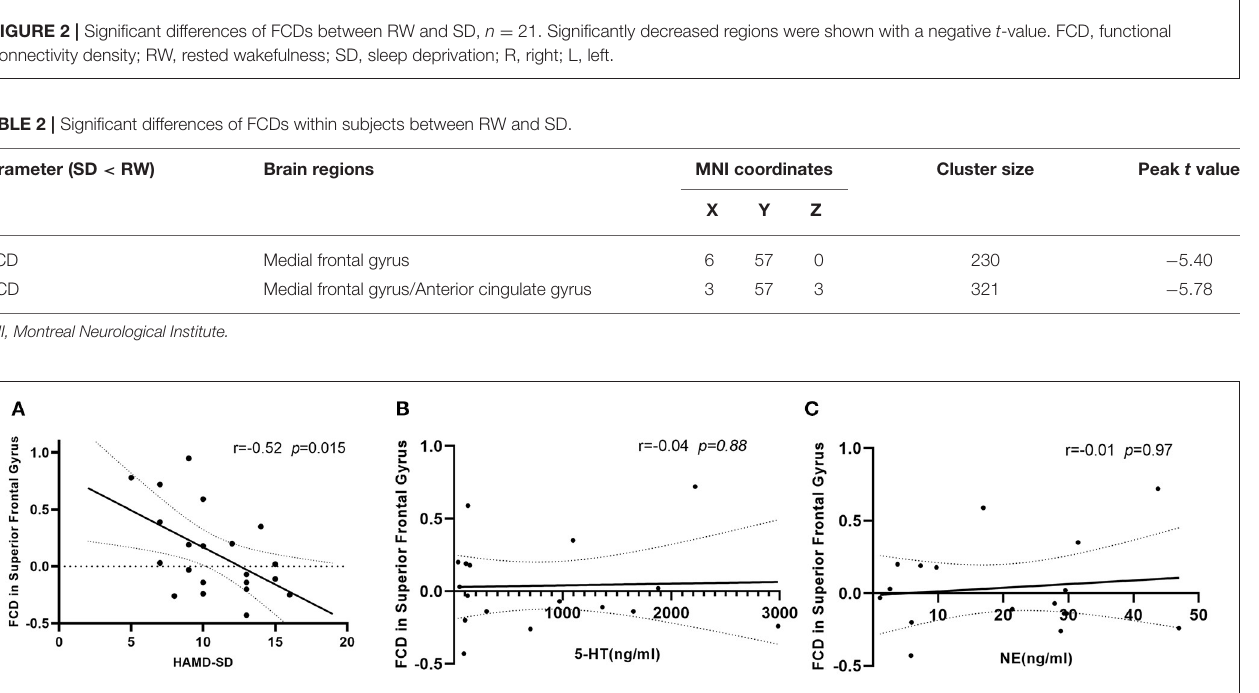
FIGURE 3 | (A) Correlation between value of lrFCD in right medial frontal gyrus and HAMD scores after SD, n = 21. (B) Correlation between value of lrFCD in right medial frontal gyrus and concentration of 5-HT after SD, n = 17. (C) Correlation between value of lrFCD in right medial frontal gyrus and concentration of NE after SD, n = 17. FCD, functional connectivity density; HAMD, Hamilton Depression Rating Scale; SD, sleep deprivation; 5-HT, serotonin; NE,